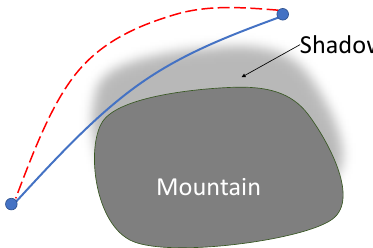
Figure 7. The red path, which is outside the shadow region, can harvest more energy but takes a longer time than the blue path, which crosses the shadow